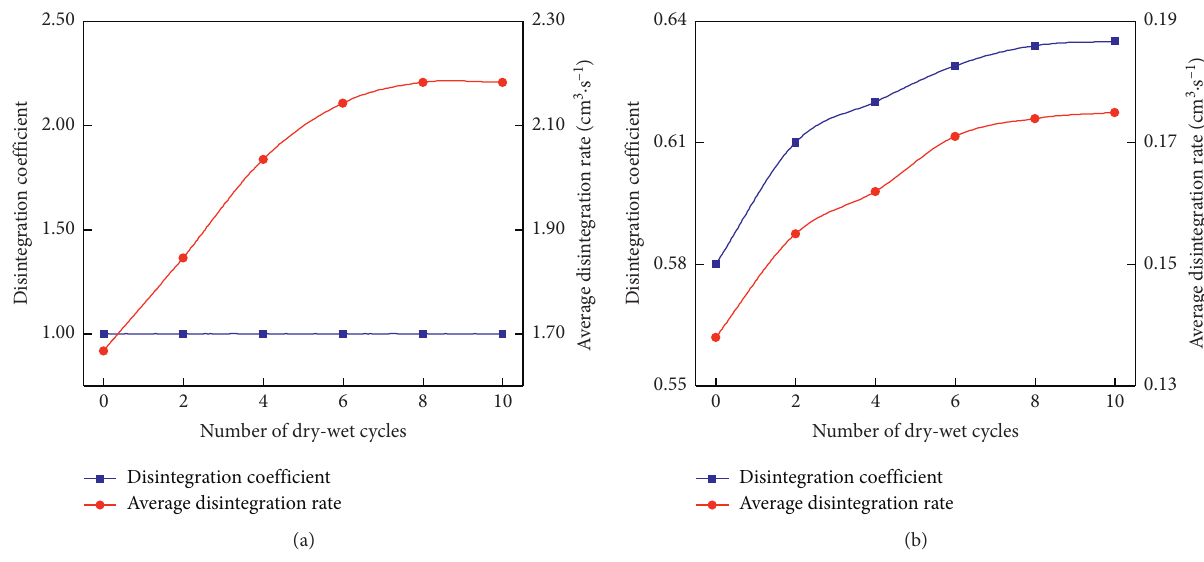
Figure 3: The effects of D-W cycles on disintegration with the number of cycles: (a) control loess; (b) fiber-reinforced